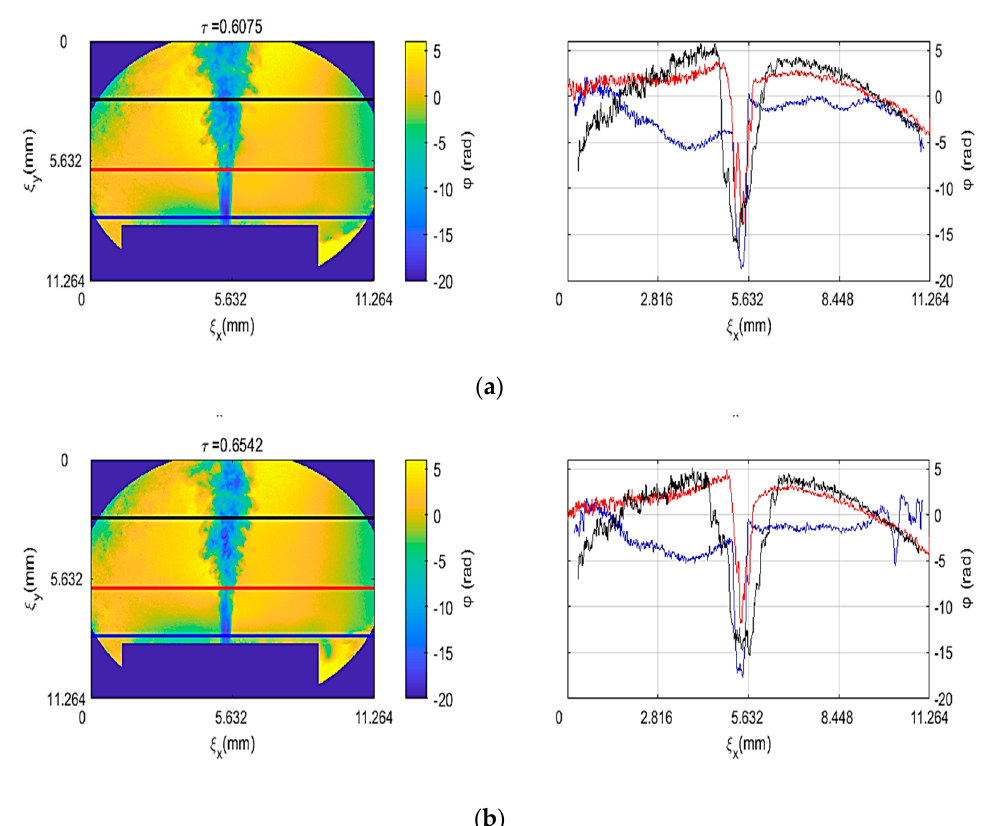
Figure 4. ( a , b ) Whole − field interference phase profile of warm water flowing out from a single circular orifice and its plot at two different relative instants.